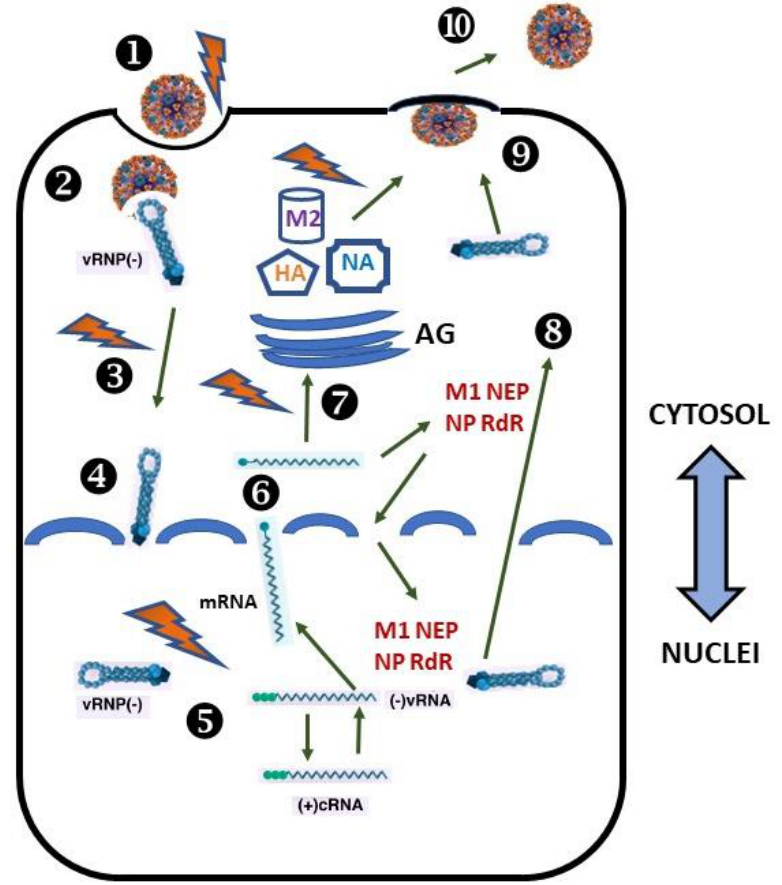
Figure 1. Schematic representation of the important steps of the IAV life cycle. Recognition and attachment (Stage 1). Viral HA (orange) recognizes the terminal α 2,6- or α 2,3-linked NANA residues in glycan of the sialo-containing receptor on the plasma membrane and attaches to them. Entry (Stage 2). Virus entry to the host cell via endocytosis. Fusion of endosomal and viral membranes and release of viral genome (Stage 3). Once inside the acidic endosomal compartment and after the structural rearrangement of HA, the lipid bilayers of the virus and endosome fuse, and a pore is formed. Transfer to nuclei (Stage 4). Viral genome packed in vRNPs is released into the cytosol through the formed pore. Transcription, replication, and assembly (Stage 5). Later, they are transferred to the nuclei. Transcription and replication of the IAV genome occur at the genomic vRNA in the nuclei. Synthesis and maturation viral proteins (Stage 6 and 7) . v-mRNAs are transported into the cytosol and translated on membrane-bound or free polyribosomes. Packaging of vRNPs (Stage 8). Viral proteins that are needed in virus assembly (M1, NP, NEP, and RNA-dependent RNA-polymerase subunits) return to the nucleus to be packaged as vRNPs. Later, they are exported to the cytosol and delivered to the plasma membrane. Budding and realizing virus particles (Stage 9 and 10). Envelope viral proteins (HA, NA, and M2) are synthesized on the rough ER and enter the cellular secretory pathway. Here, HA and NA co-translationally acquire the N-carbohydrate block, which completes their maturation in the Golgi. After that, they are transported via post-Golgi transport machinery to the PM and meet the vRNPs. Here, the budding and release of progeny viruses occur. Protein M1 assists in the formation of mature virions, using fragments of the lipid bilayer and some proteins of the host cell. The viral NA cleaves sialic acid from cell-surface glycoproteins and glycolipids, and virions are released. (i). IAV cell entry. IAV cell entry starts with recognition of a potential host and the